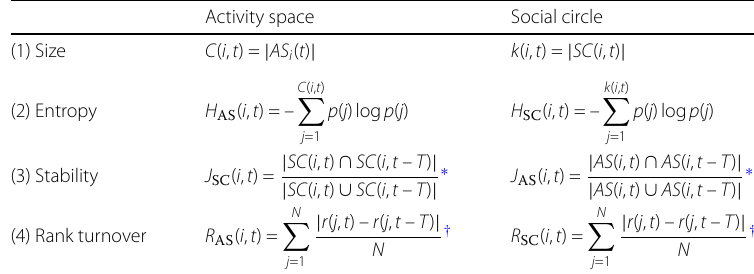
Table 2 Definition of the metrics characterising the activity space and the social circle. (1) The size of a set is the number of elements in the set. (2) We compute the entropy of a set considering the probability p ( j ) associated to each element j of the set. (3) We measure the stability J AS by computing the Jaccard similarity between the activity space at t and at t – T , with T = 20 weeks. J SC is computed in the same way for the social circle. (4) We compute the rank turnover of a set by measuring for each of its elements j the absolute change in rank between two consecutive time windows of length T = 20 weeks. The rank is attributed based on the probability p ( j ). The average absolute change in rank across all elements corresponds to the rank turnover Activity space Social